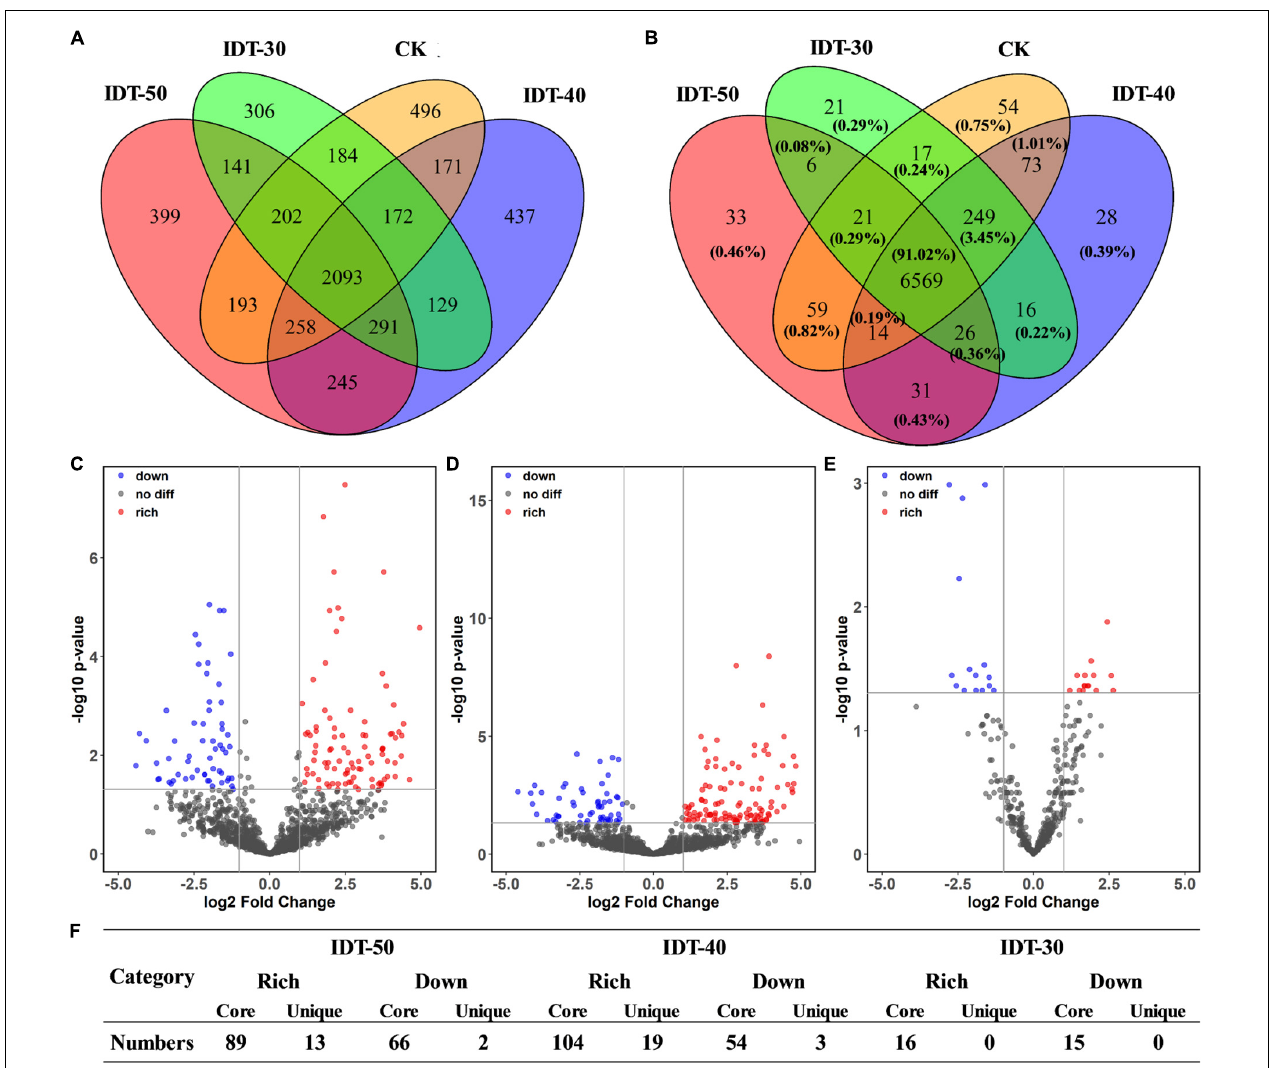
FIGURE 2 | The effects of different tillage methods on rhizosphere microbial compositions. The overlap of taxonomical OTUs (A) and functional KOs (B) in conventional tillage treatment and intermittent deep tillage (IDT) treatments. Volcano plots (C–E) represent the community compositions in IDT-50, IDT-40, and IDT-30, respectively. The rhizosphere bacterial OTUs with relative abundances significantly (log2 fold change > | 1.5| and FDR adjusted p -value < 0.05) different between IDT (red) and CK treatments are colored in the volcano plot. (F) Statistic analysis for the OTUs with relative abundances significantly different between IDT and CK